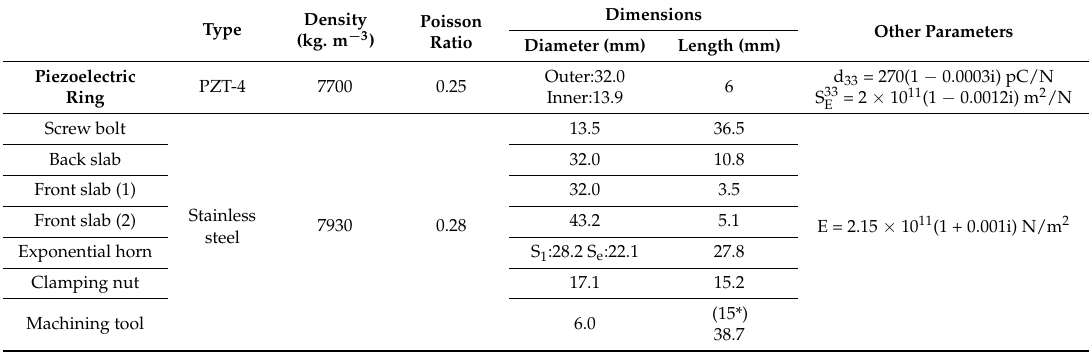
Figure 4. The experimental platform. Table 2. Properties of the ultrasonic transducer in the analytical model.